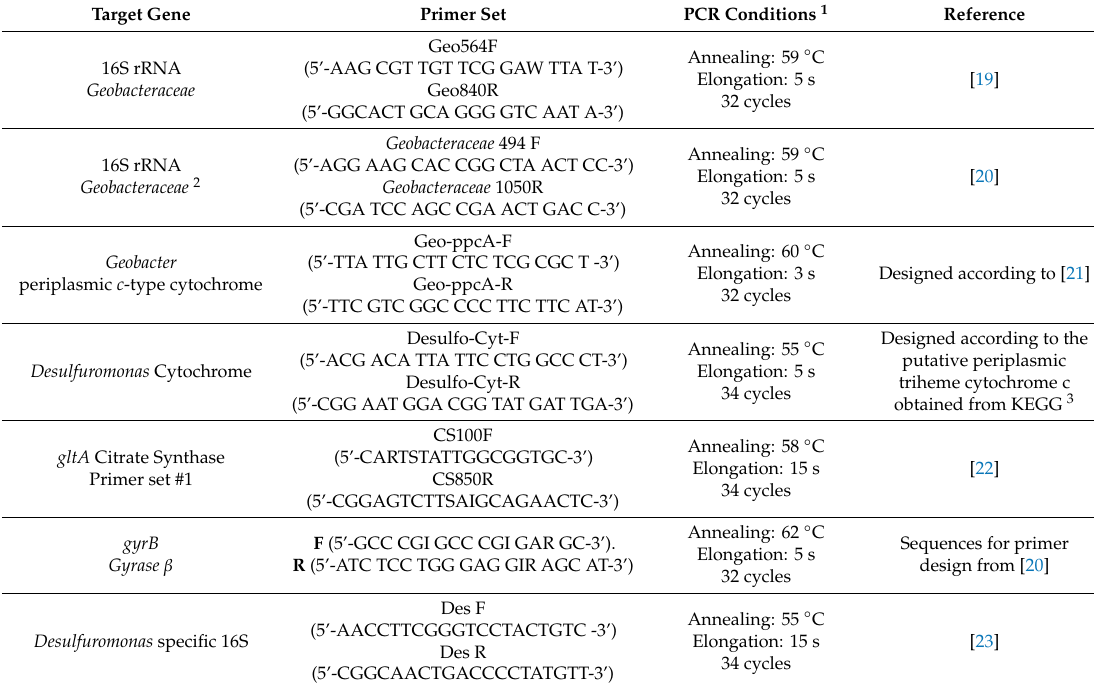
Table 1. List of primer sets used for detecting specific anode respiring